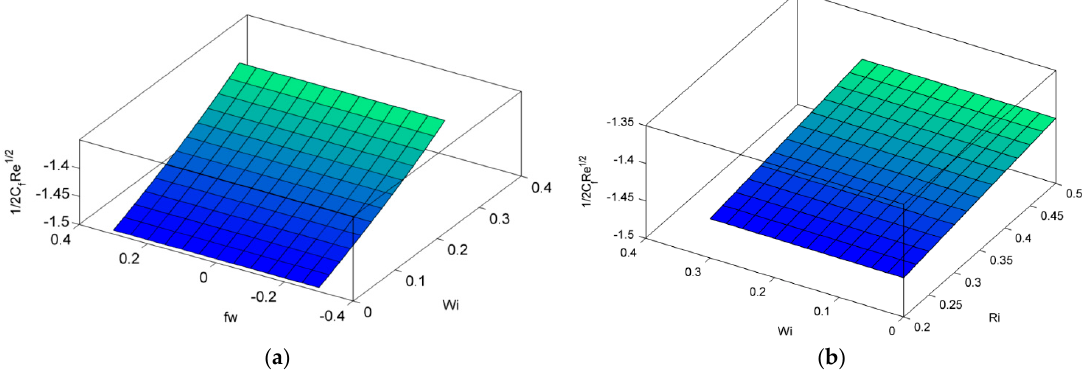
Figure 18. Three-dimensional plots of skin friction for ( a ) fw and Wi , ( b ) Ri , and Wi .